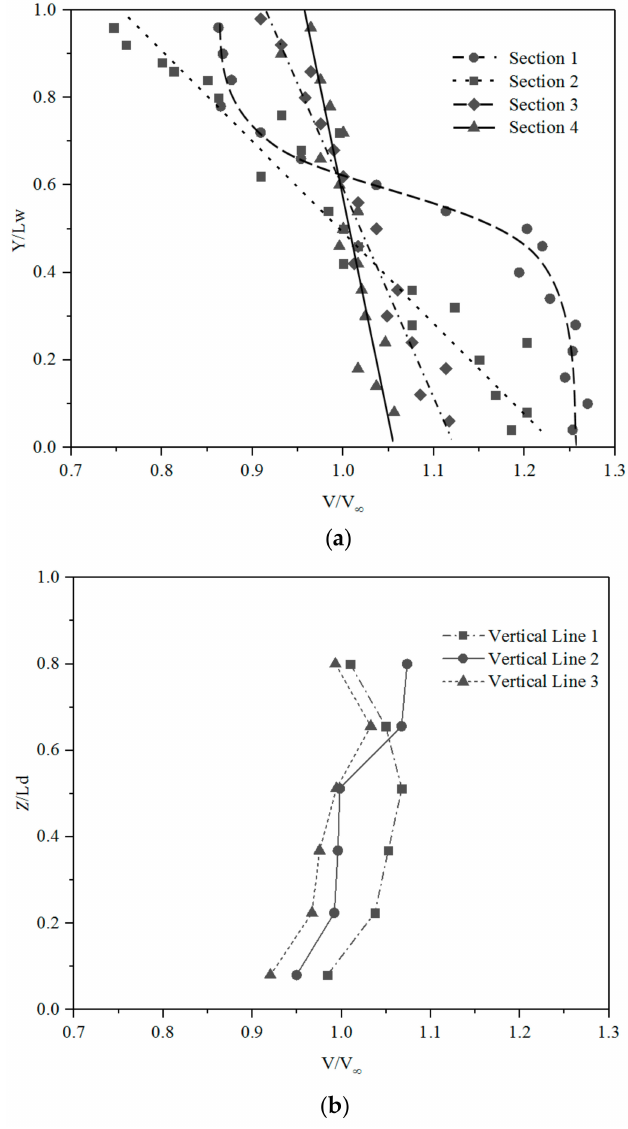
Figure 10. Velocity distributions at di ff erent locations: ( a ) Horizontal section along the channel width. ( b ) Vertical section along the channel